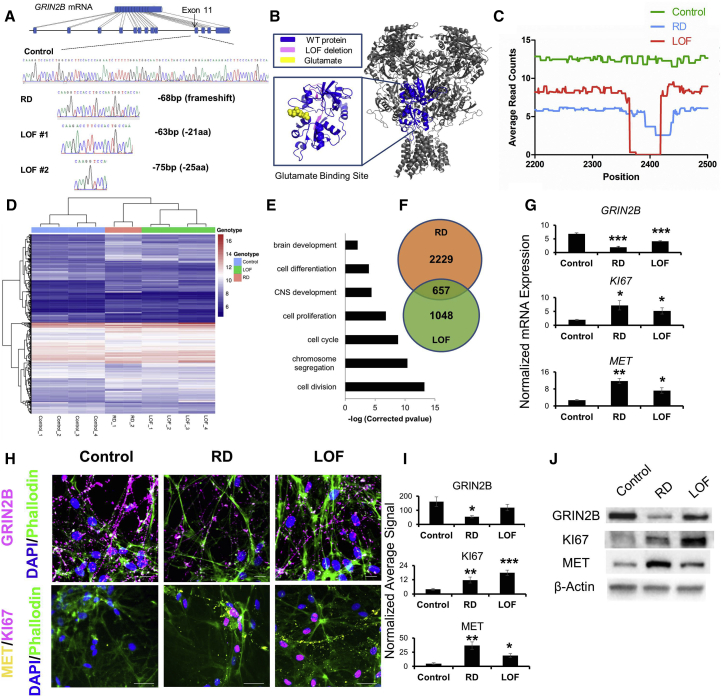
Genetically Engineered GRIN2B-Deficient Forebrain Neurons Show Impaired Differentiation(A) Location of gene-editing site within GRIN2B, Sanger sequencing of two edited lines, RD (reduced dosage) and LOF (loss of function). RD is heterozygous with only a single alteration resulting in a frame-shifted protein. LOF has two edited alleles, both of which are in-frame.(B) Structure of the NMDA receptor, with a magnified view of the glutamate binding site. The region of the glutamate binding site deleted in the LOF model is highlighted in pink.(C) RNA sequencing reads at the site of editing in transcripts obtained from control, RD, and LOF forebrain D30 neurons after 30 days of differentiation.(D) Hierarchical clustering of control, RD, and LOF D30 neurons after RNA sequencing. Heatmap of the commonly differentially expressed mRNAs in RD and LOF conditions compared with control.(E) Gene ontology terms related to significant enrichment of genes commonly deregulated in GRIN2B RD and in GRIN2B LOF differentiated neurons compared with controls. Corrected p values are expressed as −log.(F) Venn diagram showing the number of genes exclusively or commonly deregulated in GRIN2B LOF and in GRIN2B RD differentiated neurons.(G) Validation of GRIN2B, KI67, and MET mRNA differential expression in LOF and RD D30 neurons by qPCR. mRNA expression is normalized to GAPDH expression. Error bars denote SEM; n = 3 independent experiments, with each data point obtained from a separate culture of neuronal cells. ∗p < 0.05; ∗∗p < 0.01; ∗∗∗p < 0.001.(H) Representative ICC images of GRIN2B, KI67, and MET immunopositive neurons in control, RD, and LOF conditions. Neurons were fixed at D30 of differentiation. Scale bars represent 50 μm.(I) Quantification of GRIN2B, KI67, and MET signals in control, RD, and LOF D30 neurons. The expression level expressed as normalized average signal is: (mean KI67 or MET pixel intensity) × (number of pixels above threshold/number of DAPI-positive pixels). Error bars denote SEM; n = 3 independent experiments, with each data point representing quantifications of coverslips obtained from separate cultures of each cell line. ∗p < 0.05; ∗∗p < 0.01; ∗∗∗p < 0.001.(J) GRIN2B, KI67, and MET western blots of lysates from control, LOF, and RD forebrain neurons at D30.See also Figure S5.